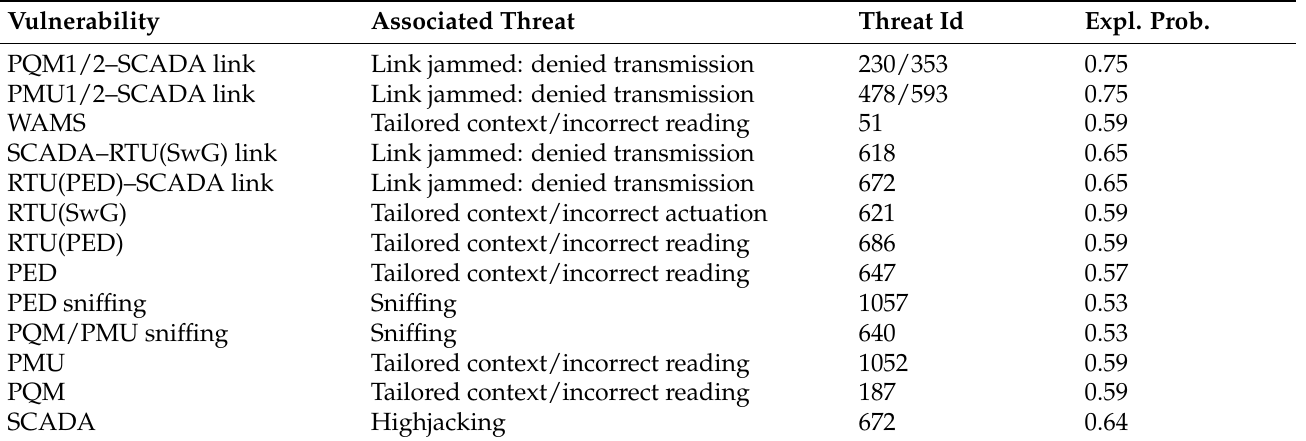
Table 14. Vulnerabilities, exploitation probabilities and associated threats for